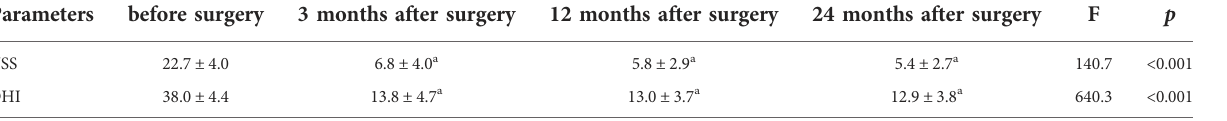
TABLE 4 VSS and DHI scores before and after surgery (x±, n =79).